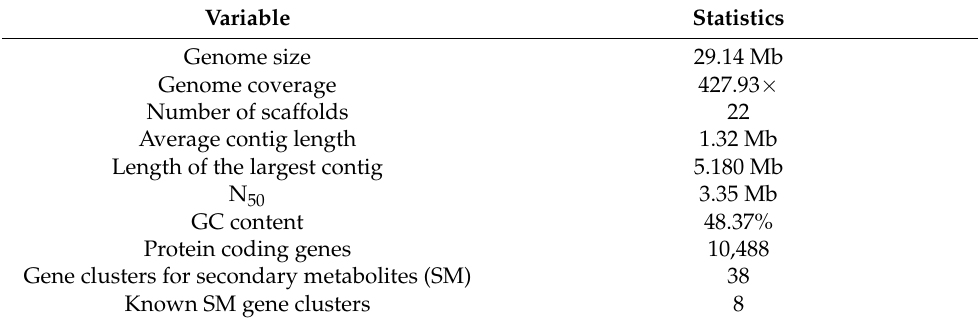
Table 2. Summary statistics of the Simplicillium lamellicola the JC-1 strain genome.